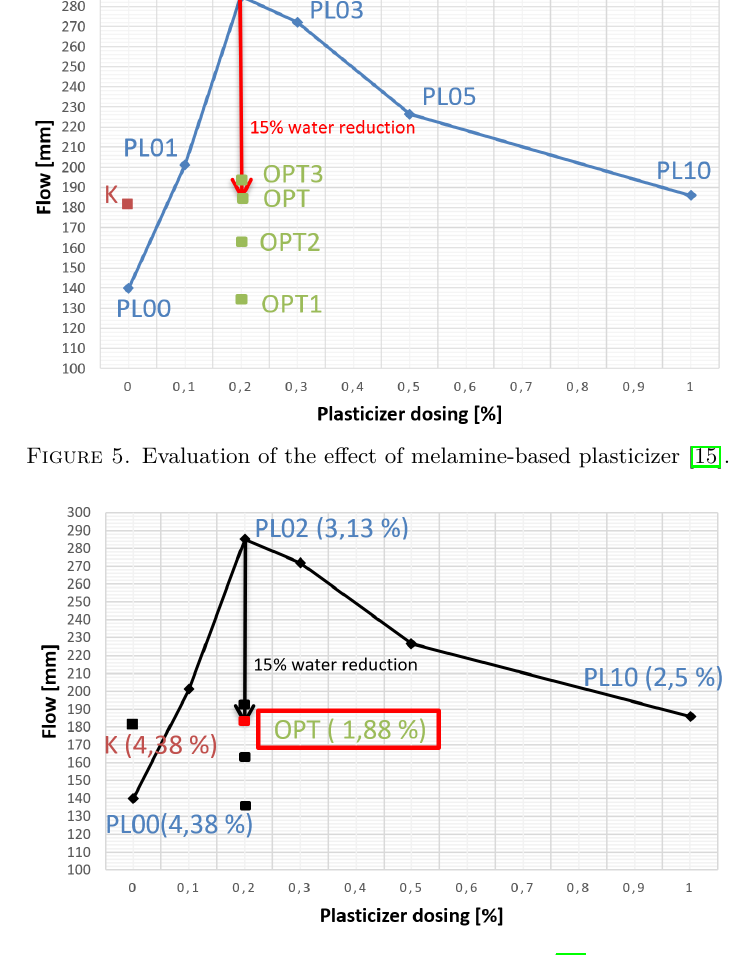
Figure 6. Shrinkage of clay mixtures